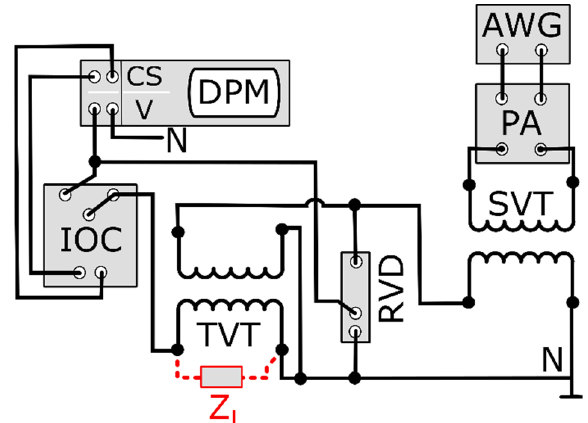
Figure 9. Blocks diagram of the measuring setup for the application of the opto-isolation circuit to determine the values of the composite error of the inductive